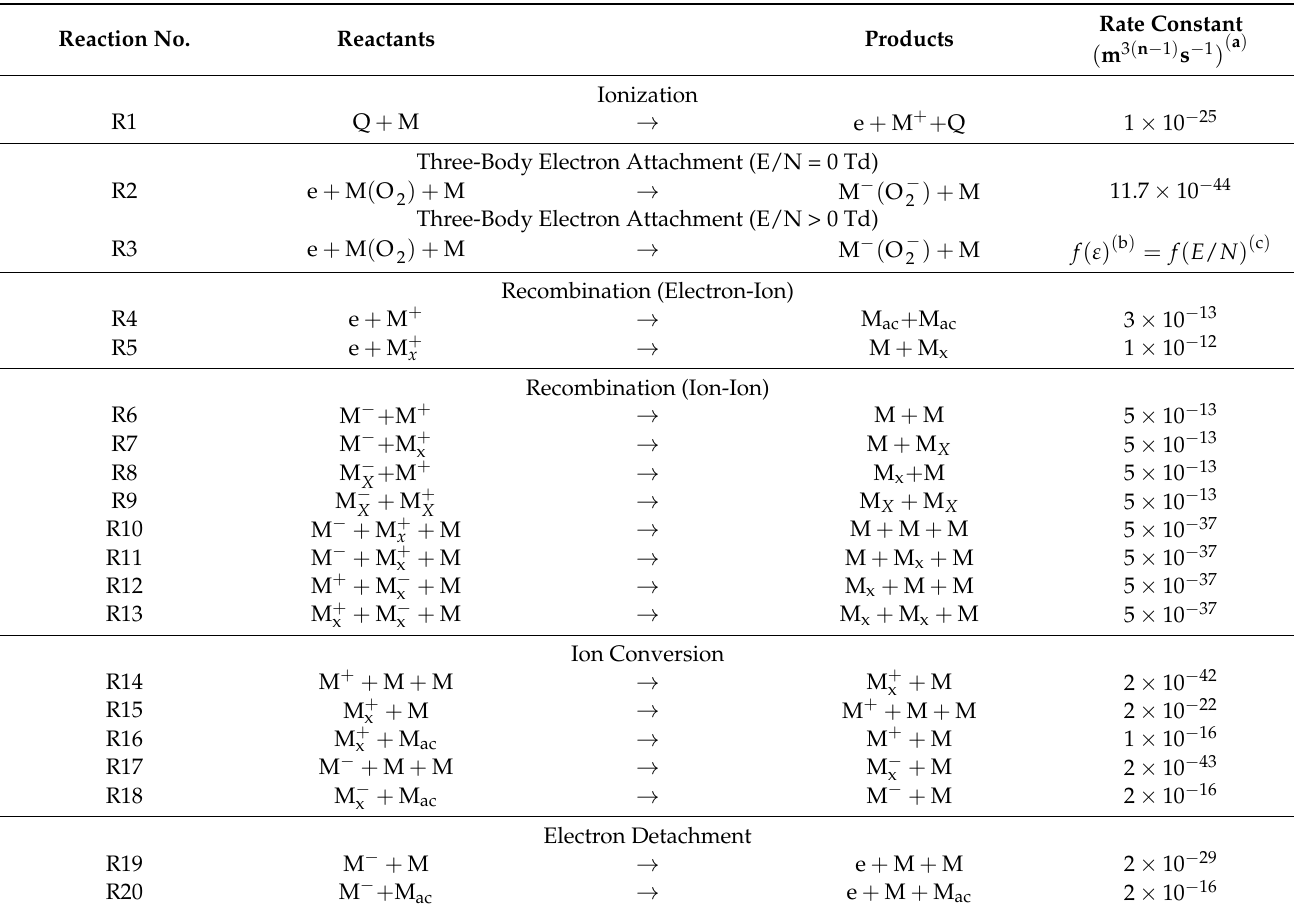
Table 2. The set of chemical reactions that describe the steady-state night-time ion chemistry model of the lower ionosphere (taken from reference